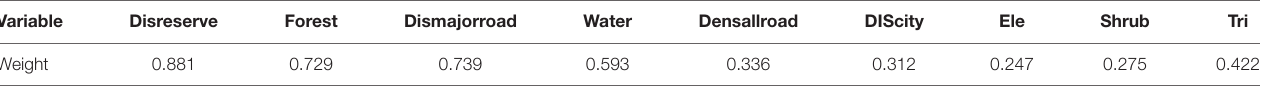
TABLE 2 | The weight of every factor for the model of the Asiatic Black Bear distribution. Variable Disreserve Forest Water